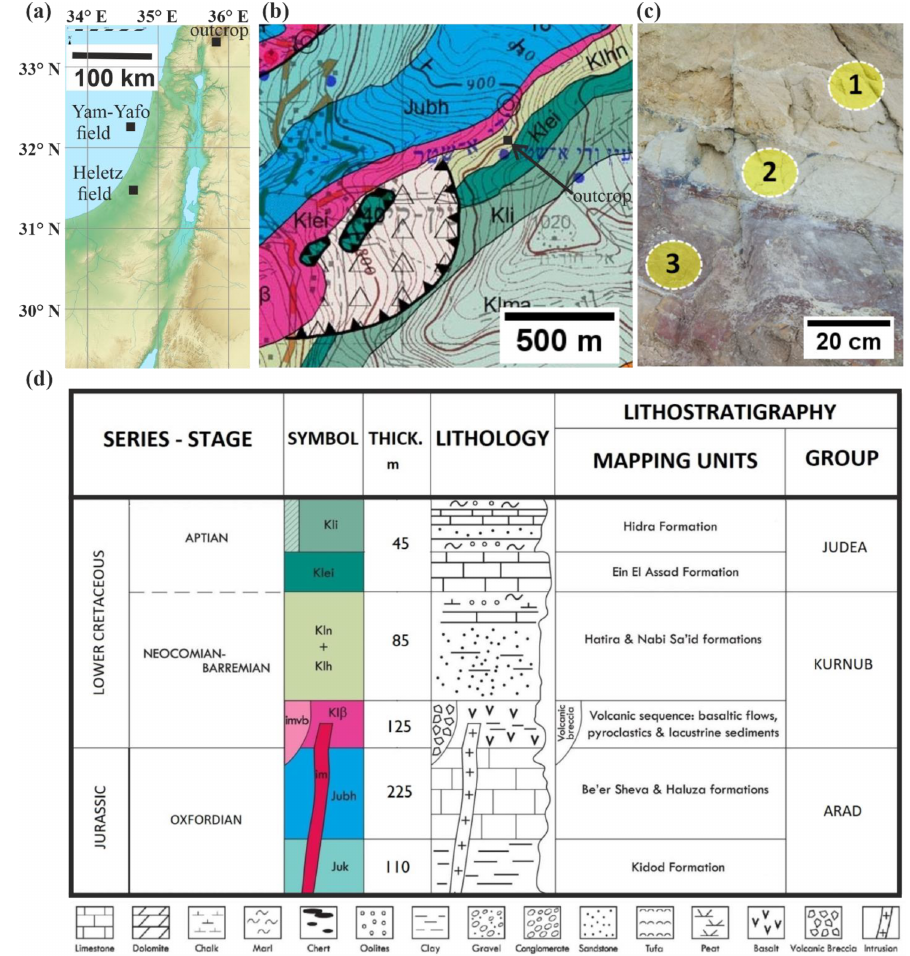
Figure 1. Geographical and geological settings. (a) Schematic relief map of Israel (modified from https://www.mapsland.com/asia/israel/ large-relief-map-of-israel, last access: March 2021). (b) Geological map of Ein Qiniyye. The Hatira Fm. sandstone and the overlying lime- stone and marl of the Nabi Said Fm. are marked as Klhn (map is adopted from Sneh and Weinberger, 2014). (c) Outcrop of the Lower Cretaceous Hatira Fm. sandstones (Klhn) at Ein Qiniyye. The studied sandstone layers have distinct colours: yellow–brown (1), grey–green (2) and red–purple (3). (d) Stratigraphic table of the geological map (modified from Sneh and Weinberger,